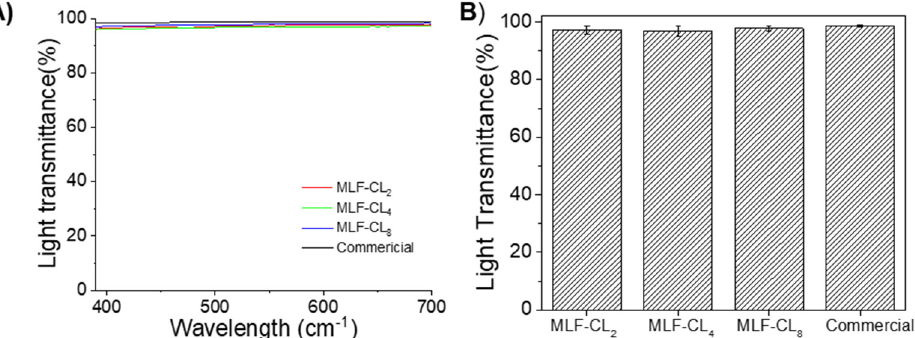
Figure 4. ( A ) Light transmittance curve of commercial lens and central aperture of MLF-CL through the visible light spectrum (from 390 nm to 700 nm). ( B ) The average light transmission of MLF-CL, which was calculated by averaging the transmission over the visible light spectrum (390–700 nm). n = 4 lens per group. Quantitative data are expressed as mean ± standard deviation (SD). No significant difference in average light transmittance between the commercial contact lenses and MLF-CL was observed ( p = 0.15, Kruskal–Wallis Test).